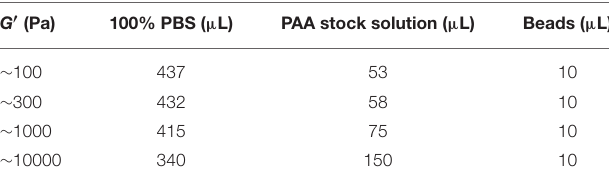
TABLE 1 | Components of PAA substrates for traction force